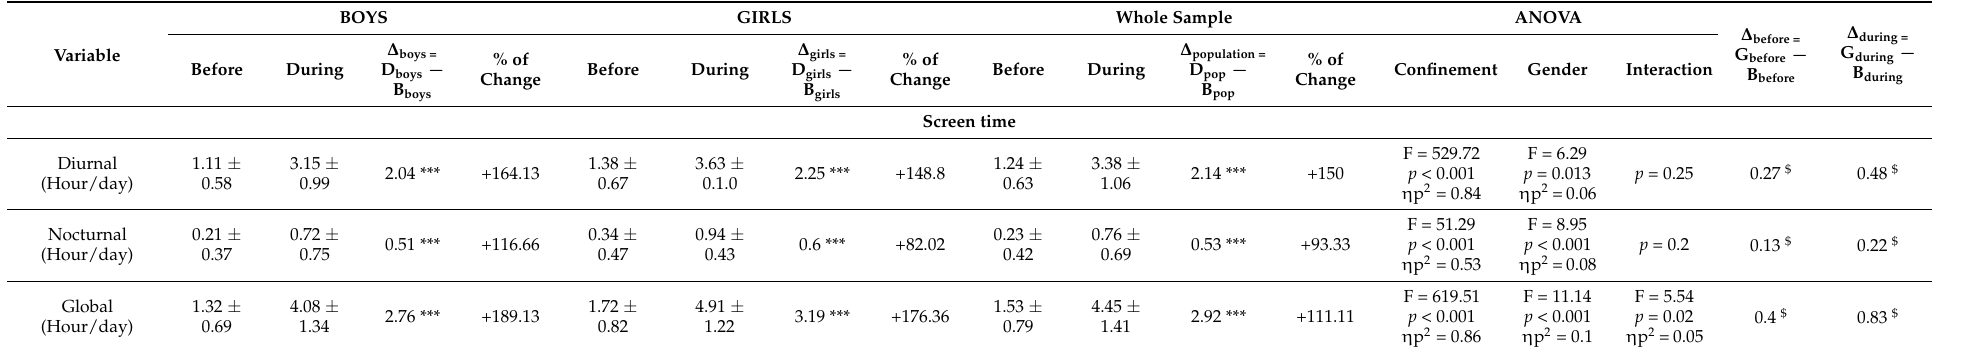
Table 3. Responses to daily screen time questionnaire recorded before and during home confinement.